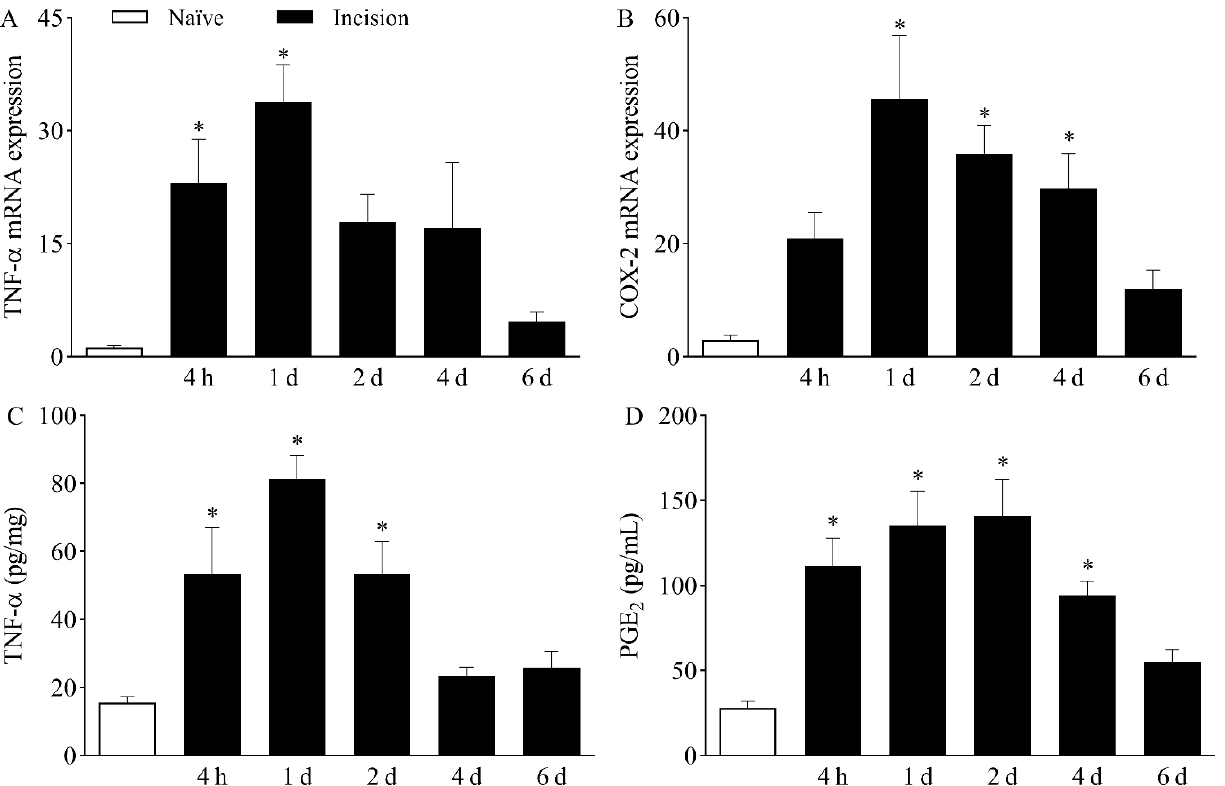
Figure 3. Increased expression of TNF- α and COX-2 /PGE 2 following plantar incision. Mice were induced to the plantar incision model of postoperative pain. No surgical procedures were performed on naïve mice. ( A , B ) The levels of TNF- α mRNA ( A ) and COX-2 mRNA ( B ) in the DRG (axis of ordinates) were determined by Real-Time PCR at different times in hours (h) and days (d) after plantar incision (axis of abscissas). Target gene expression (2 − ∆∆ Ct ) was determined using Gapdh as housekeeping gene. Data are expressed as means ± SD ( n = 6). * p < 0.05 compared with